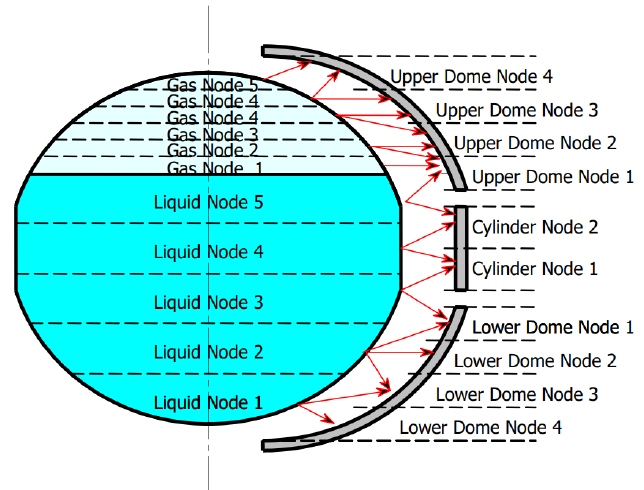
Figure 2. Cryotank exemplary fluid and wall